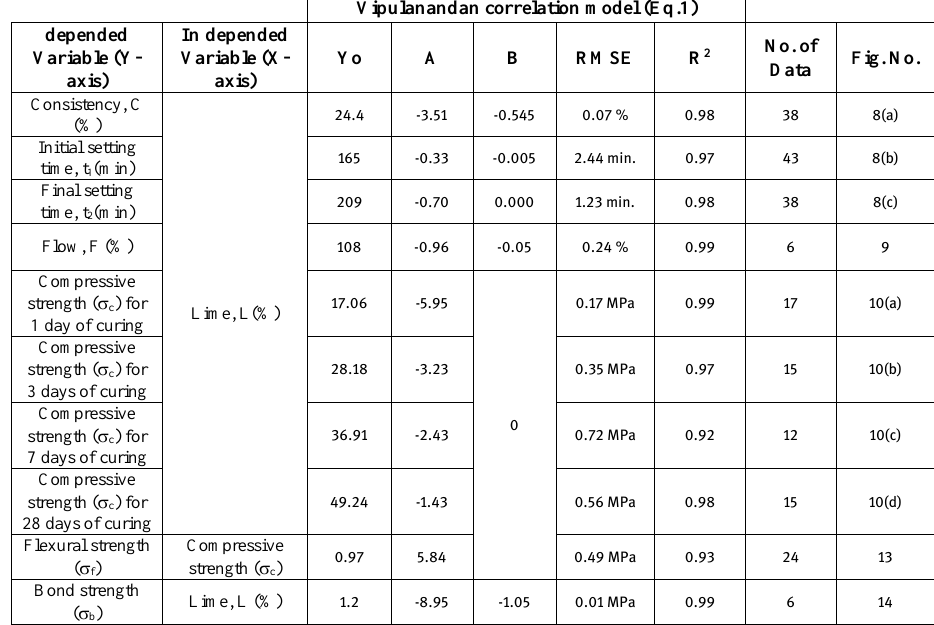
Vipulanandan correlation model (Eq.1)